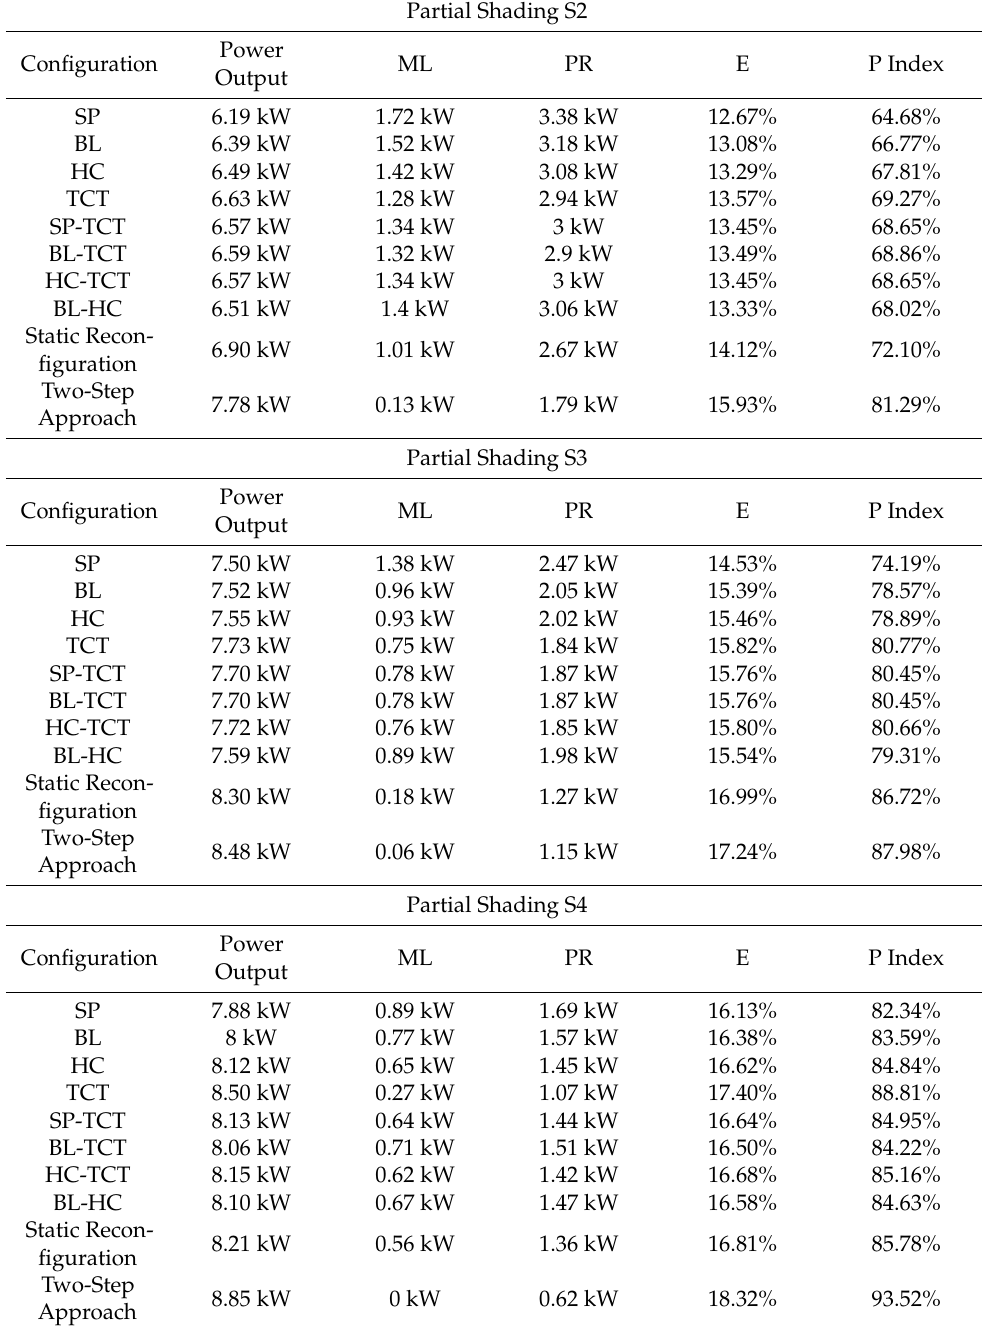
8.21 kW 0.56 kW 1.36 figuration